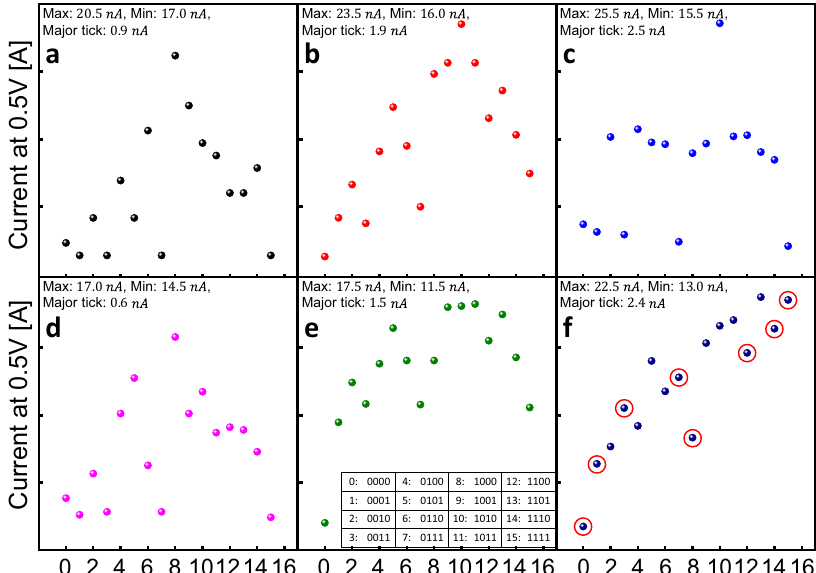
Fig. 3 Experiment results to analyze the effect of changing parameters on the kernel characteristics in the temporal kernel system. The read current at 0.5 V of the memristor for the pulse stream ‘ 0000 ’–‘ 1111 ’ that corresponds to 0 – 15 in the inset table in ( e ). a The read current at 0.5 V of the memristor for each input under the conditions of 1 M Ω R L , 4 V signal pulse height, 100 µ s width, 4 V REF pulse height, and 100 µ s width. b – e The read current at 0.5 V of the memristor for each input when R L , pulse width, pulse height, and REF pulse height are changed respectively from the condition of ( a ). The various parameter settings for each fi gure were summarized in Table 1. The kernel responses for each input of the temporal kernel optimized for the MNIST recognition are shown in ( f ). Responses to inputs showing high prevalence in the dataset were well separated (marked by red